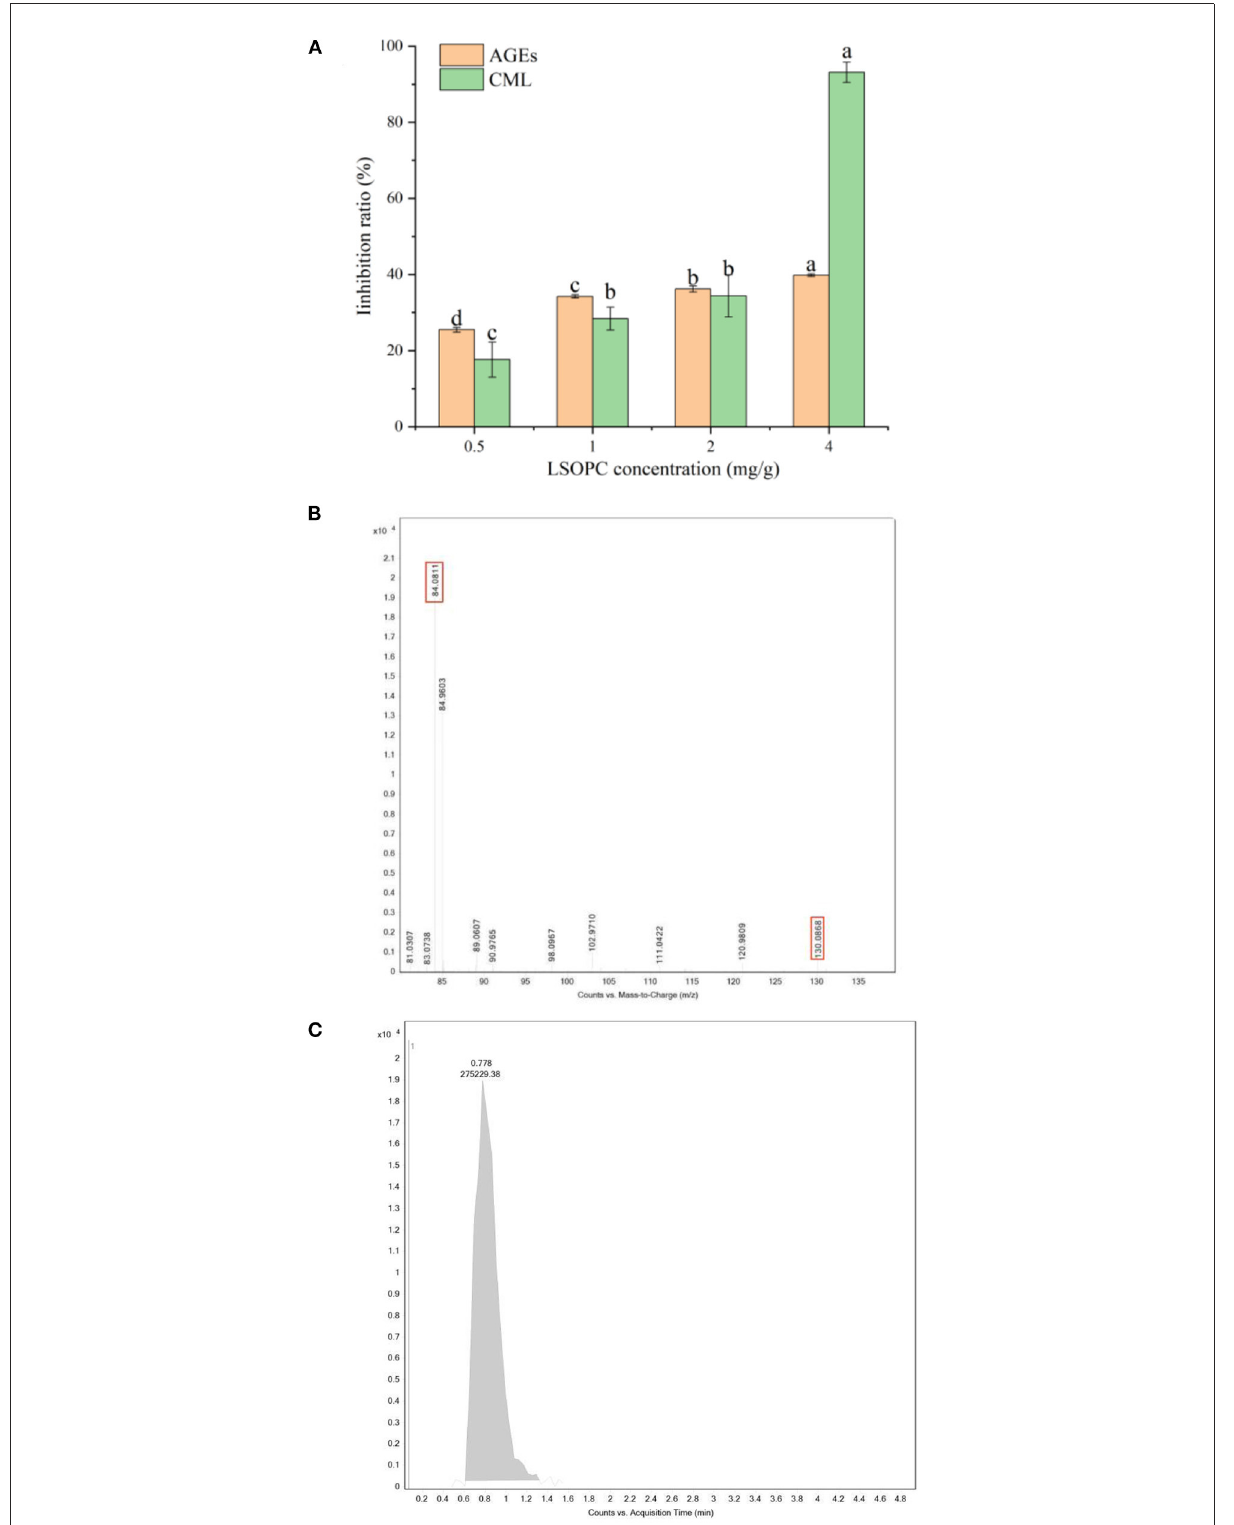
FIGURE1 Effect of different concentrations of LSOPC on inhibition rate of AGEs and CML in biscuits (A) . CML: ion spectra of the standard substance (B) . CML: peak area of the standard substance (C) . Significant differences ( p < 0.05) of data values were indicated by different letters.